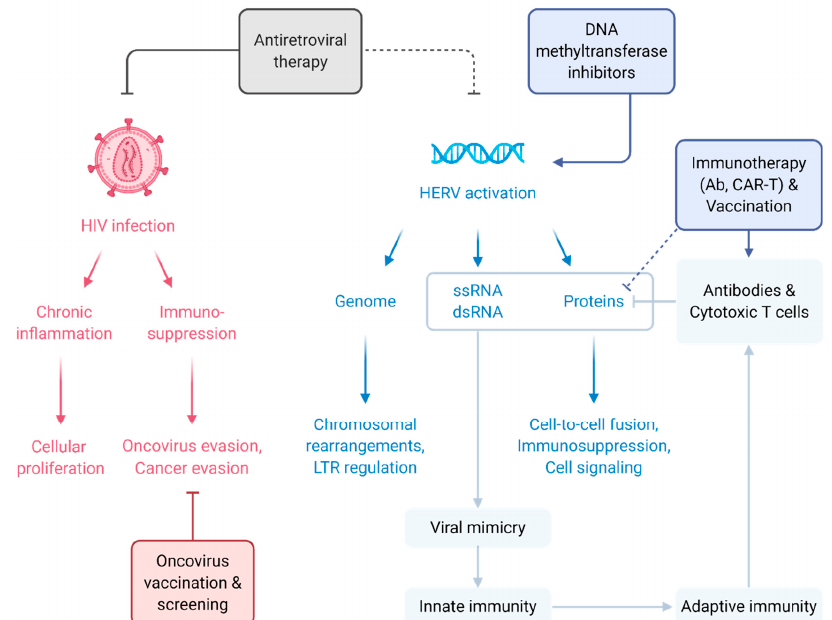
Figure 1. Illustration of the HIV– and HERV–cancer relationships and potential treatment strategies. HIV infection creates a dysregulated environment with chronic inflammation and immunosuppression that aid oncovirus transformation and cancer development (solid red arrows). Strategies to preclude HIV-related cancers include antiretroviral therapies (solid grey T bar) and oncovirus screening/vaccination (solid red T bar). As for HERV, activation and expression of HERV nucleic acid and protein elements have been found in various cancers, potentially contributing to cancer development (solid blue arrows). The aberrant expression of HERV elements has a viral mimicry e ff ect that triggers innate and adaptive immune responses (solid light blue arrows), which have been exploited as approaches to fight HERV-associated cancers (solid light blue T bar). Inducing HERV expression through DNA methyltransferase inhibitors (solid dark blue arrow), immunotherapies targeting HERV proteins (dotted dark blue T bar and solid dark blue arrow), and antiretroviral therapies (dotted grey T bar) are being explored as potential anti-cancer therapies. Figure created with